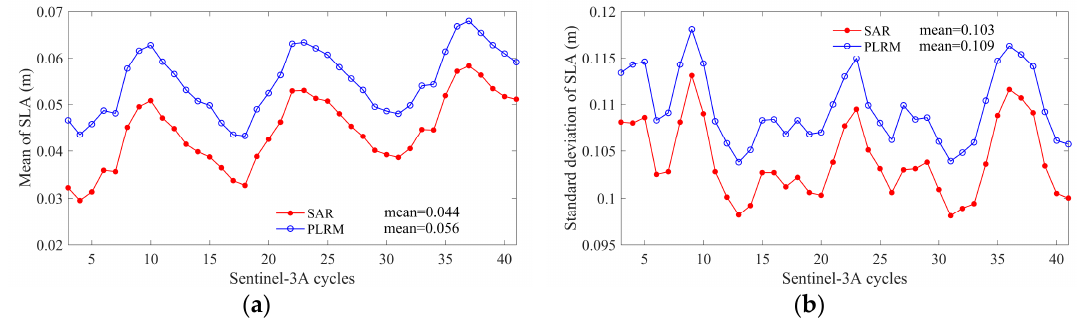
Figure 16. Cycle by cycle ( a ) means and ( b ) standard deviations of SLA according to Sentinel-3A repeat cycles.